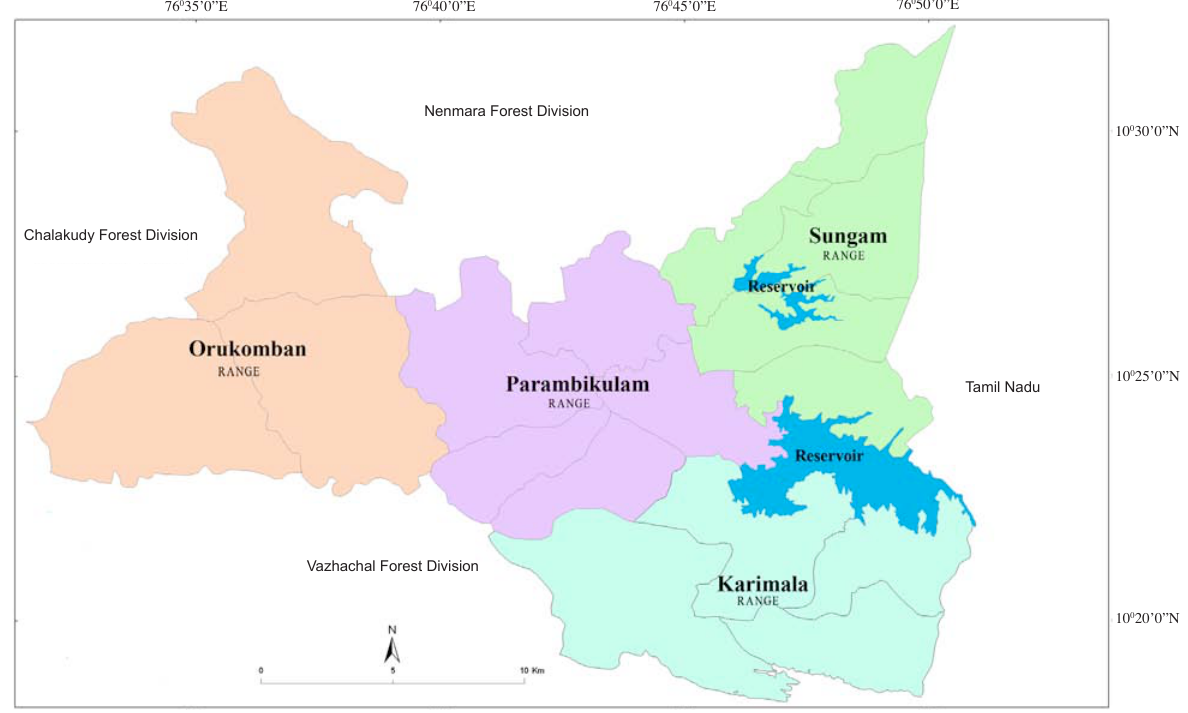
Figure 1. Map of Parambikulam Tiger